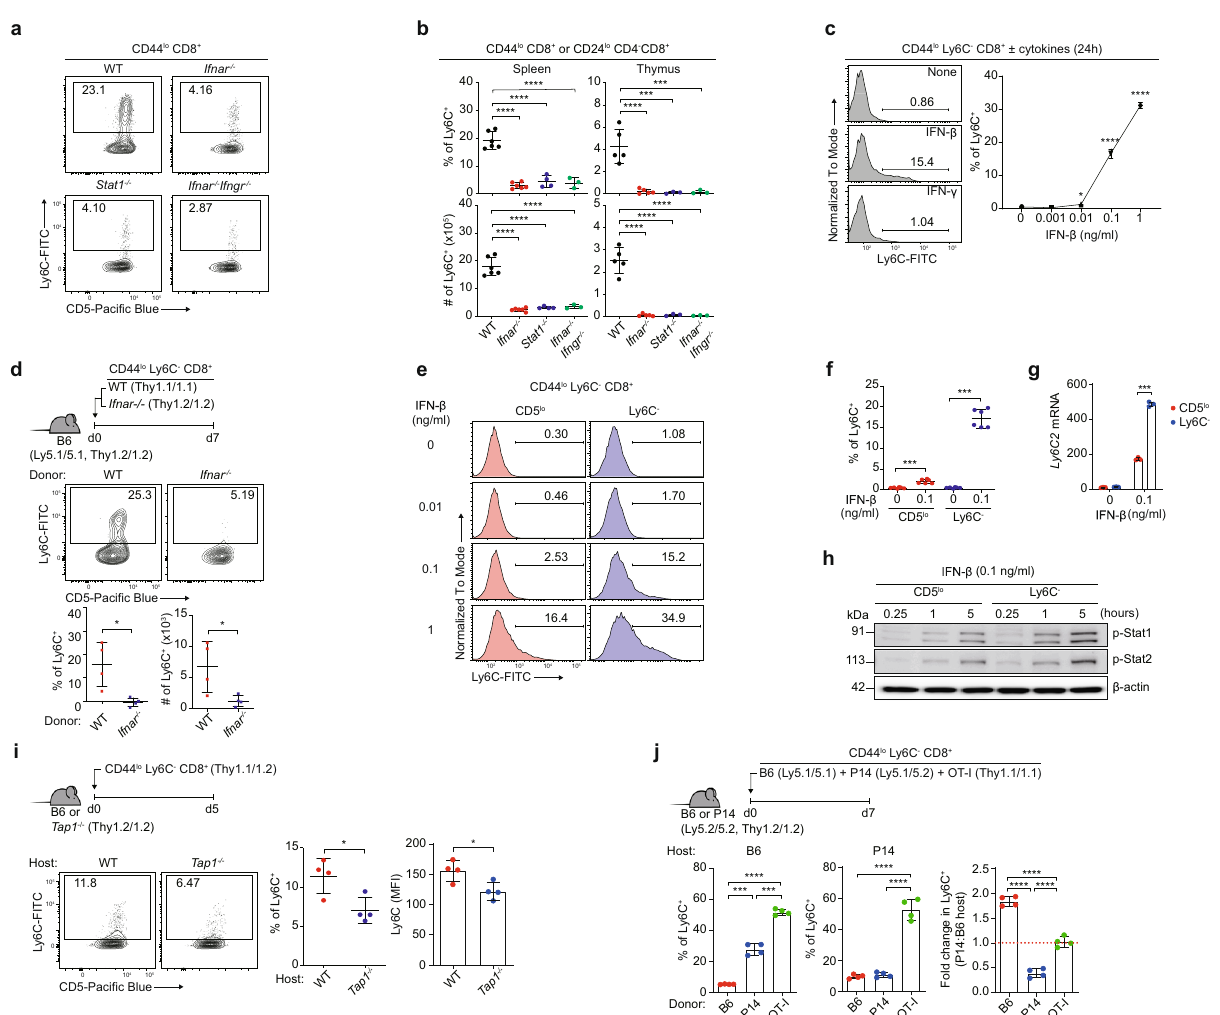
Fig. 2 Type I IFN and self-TCR are crucial for inducing Ly6C + naive CD8 + T cells. a Percentage of B6 Ly6C + naive CD8 + T cells in spleen from different type I IFN signal de fi cient mice. b Percentage and absolute number of B6 Ly6C + naive CD8 + T cells in spleen and thymus from different type I IFN signal de fi cient mice ( n = 6 for WT, n = 6 for Ifnar − / − , n = 4 for Stat1 − / − , n = 3 for Ifnar − / − Ifngr − / − mice). c Percentage of induced Ly6C + cells from B6 Ly6C − naive CD8 + T cells in vitro ( n = 3 mice for each group). d Percentage and absolute number of induced Ly6C + cells from WT and Ifnar − / − B6 Ly6C − naive CD8 + T cells in vivo ( n = 4 mice for each group). e, f Percentage of induced Ly6C + cells from CD5 lo and Ly6C − B6 naive CD8 + T cells cultured with IFN- β ( n = 6 mice for each group). g mRNA expression of Ly6 c 1 from CD5 lo and Ly6C − B6 naive CD8 + T cells cultured with IFN- β (n = 3 mice for each group). h Phosphorylation of STAT1 and STAT2 in CD5 lo and Ly6C − cells cultured with IFN- β . i Percentage of induced Ly6C + cells and Ly6C MFI from B6 Ly6C − naive CD8 + T cells transferred to WT or Tap1 − / − hosts ( n = 4 mice for each group). j Percentage of induced Ly6C + cells from B6, P14, or OT-I Ly6C − naive CD8 + T cells transferred to B6 or P14 hosts ( n = 4 mice for each group). Statistical signi fi cance was con fi rmed by two-tailed unpaired Student ’ s t - test. Results are shown as mean ± SD. Data representative of 2-3 independent experiments. Source data are provided as a Source data fi levels (Fig. 2e – g). This disparate sensitivity was not attributed to the different levels of IFNAR (IFNAR1 and IFNAR2; Supple- notype (Supplementary Fig. 2d, e). mentary Fig. 2g) but rather to the variation in the extent of downstream signaling, as evidenced by stronger IFN- β -induced STAT1/2 phosphorylation in CD5 hi than in CD5 lo cells (Fig. 2h). Given the greater self-reactivity of CD5 hi cells (Nur77 hi ; Supplementary Fig. 2h) 18 , we next examined whether self-TCR signaling indeed affects the sensitivity of T cells to type I IFN. The following three observations support this phenomenon. First, IFN- β -induced Ly6C expression levels were increased signi fi - cantly upon treatment with soluble anti-CD3 (Supplementary Fig. 2i). Second, Ly6C + cells were poorly synthesized in Tap1 − / − hosts that were adoptively transferred with Ly6C − CD8 + donor cells (Fig. 2i). Third, most importantly, when Ly6C − B6, P14, and OT-I CD8 + T cells were co-transferred to B6 hosts, Ly6C + cell